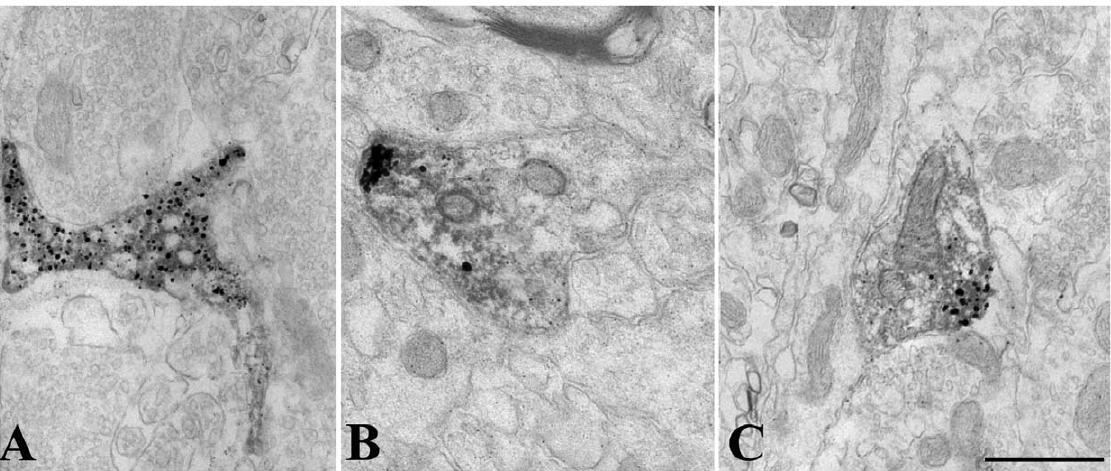
Figure 8. Ultrastructure of MCT8 immunoreactive structures in the rat median eminence. MCT8-immunoreactivity (silver grains) is associated with tanycyte ( A ) and axon varicosities ( B, C ) in the external zone of the median eminence. In the axon varicosities, silver grains accumulate in a small region of the varicosity close to the cytoplasmic membrane ( B, C ). Scale bar: 500 nM.